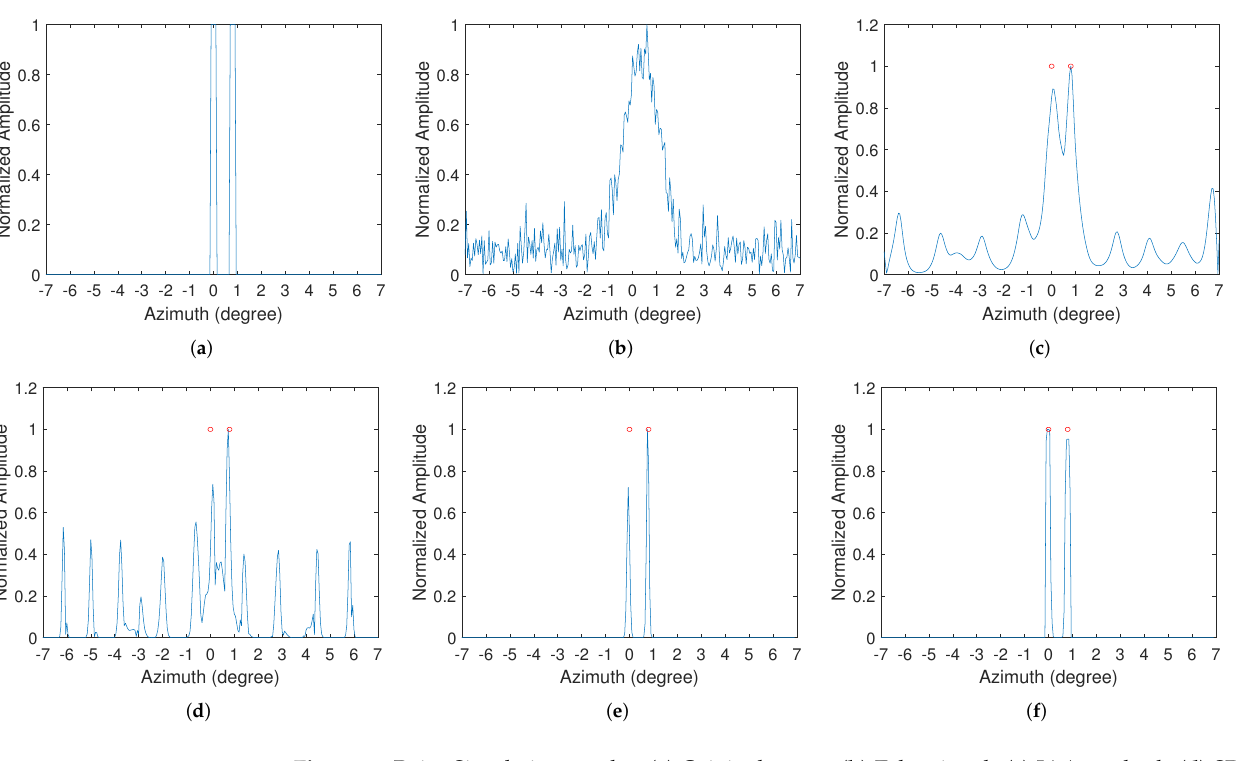
Figure 6. Point Simulation results. ( a ) Original scene. ( b ) Echo signal. ( c ) IAA method. ( d ) SPICE method. ( e ) GMM-LP method. ( f ) Multi-prior Bayesian method. (The red circles are the ideal locations of the targets’ scattering).